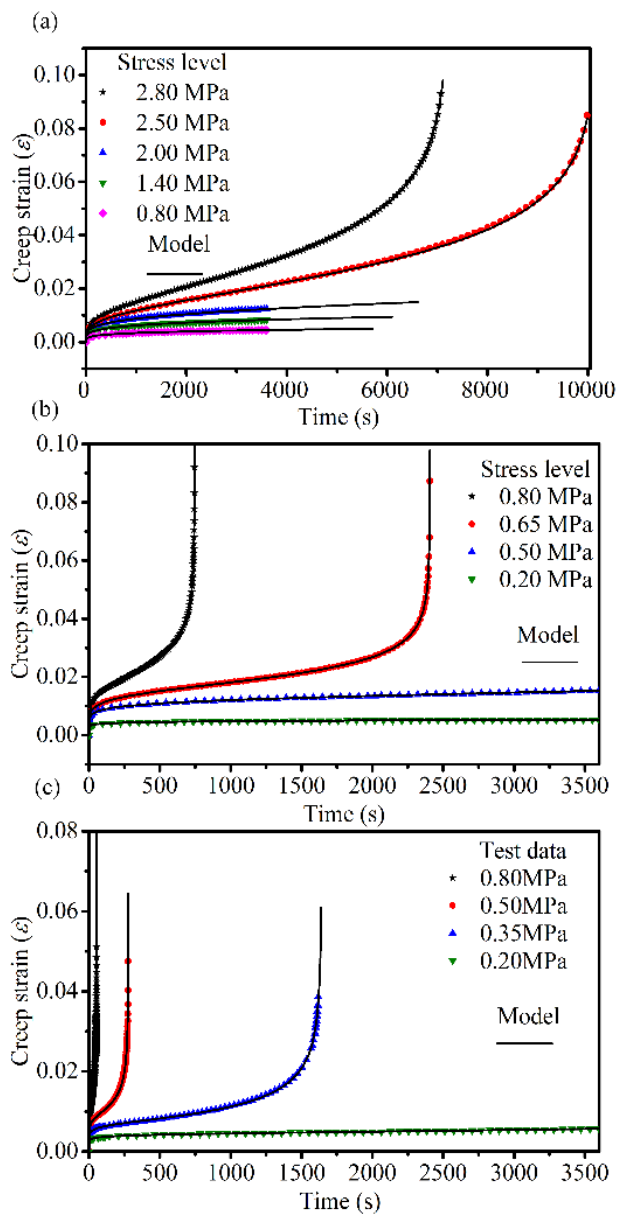
Figure 7. Comparison between the tests data of the creep tests and the fractional derivative creep damage model predicted creep curves at ( a ) 10 °C, ( b ) 30 °C, and ( c ) 50 °C.